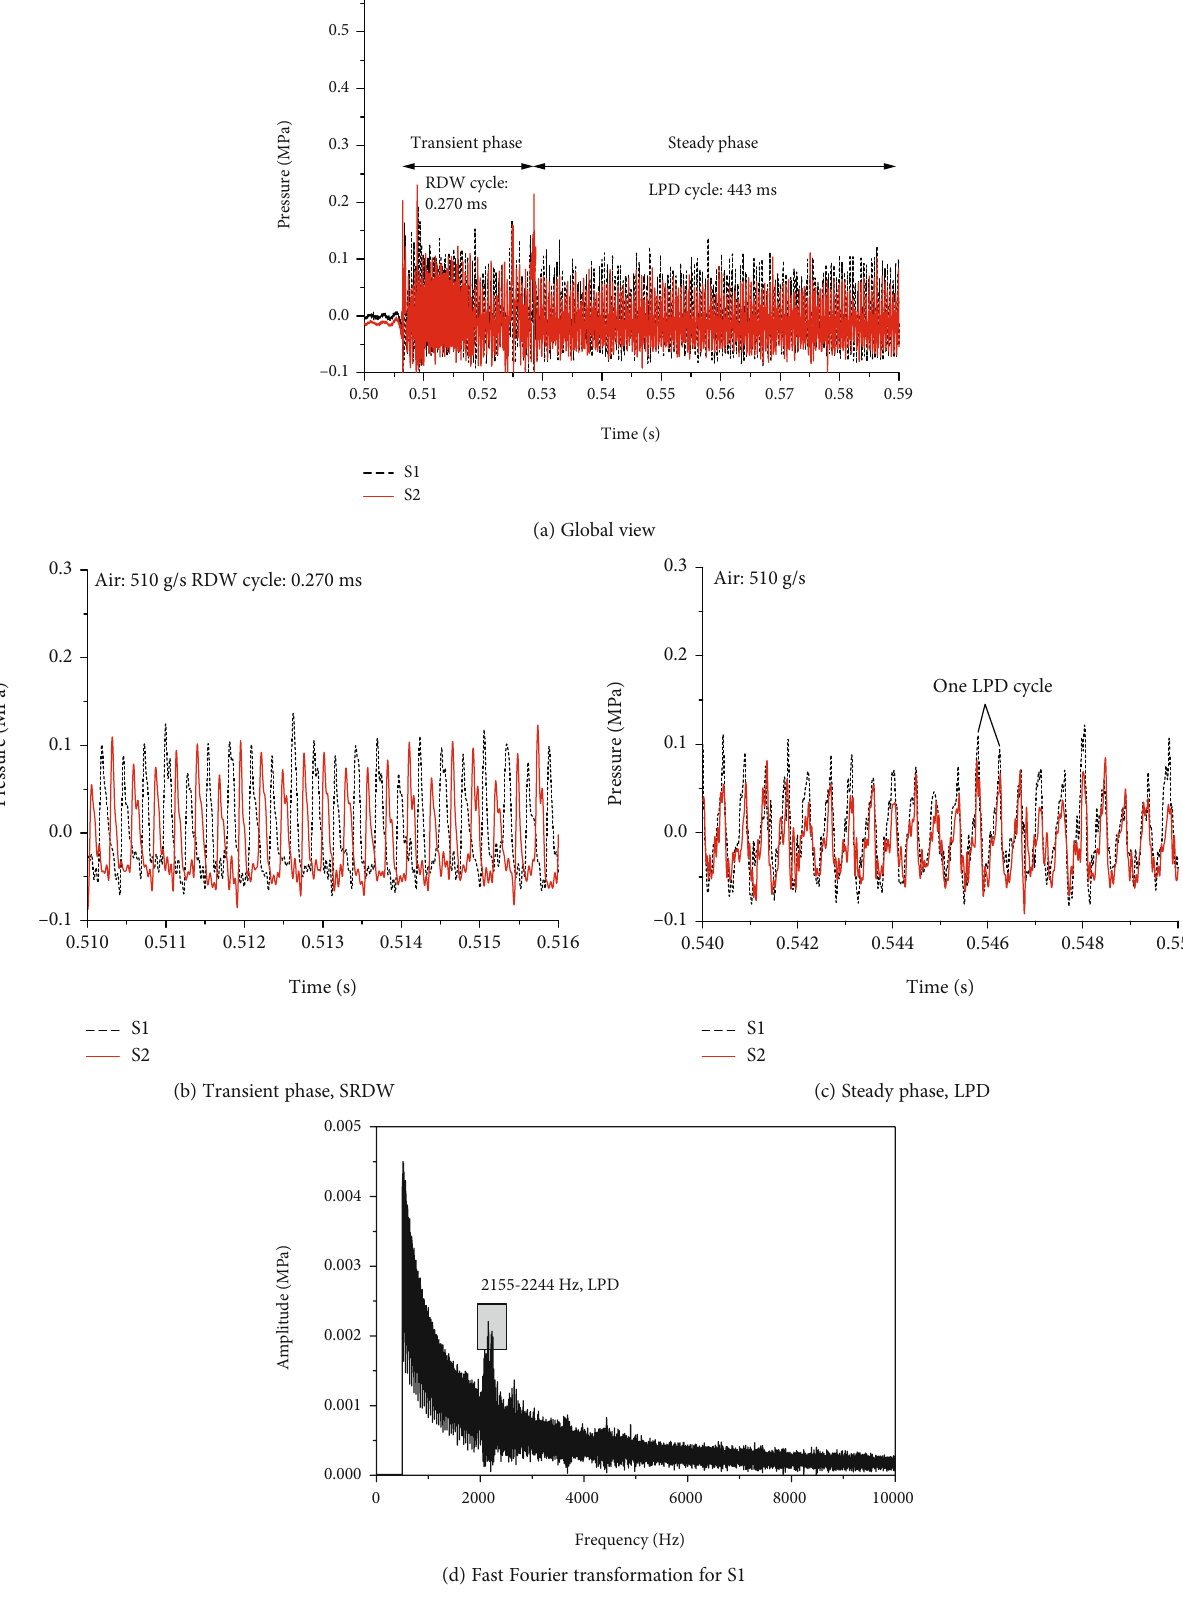
Figure 5: Pressure traces obtained by S1 and S2 for the air mass fl ow rate